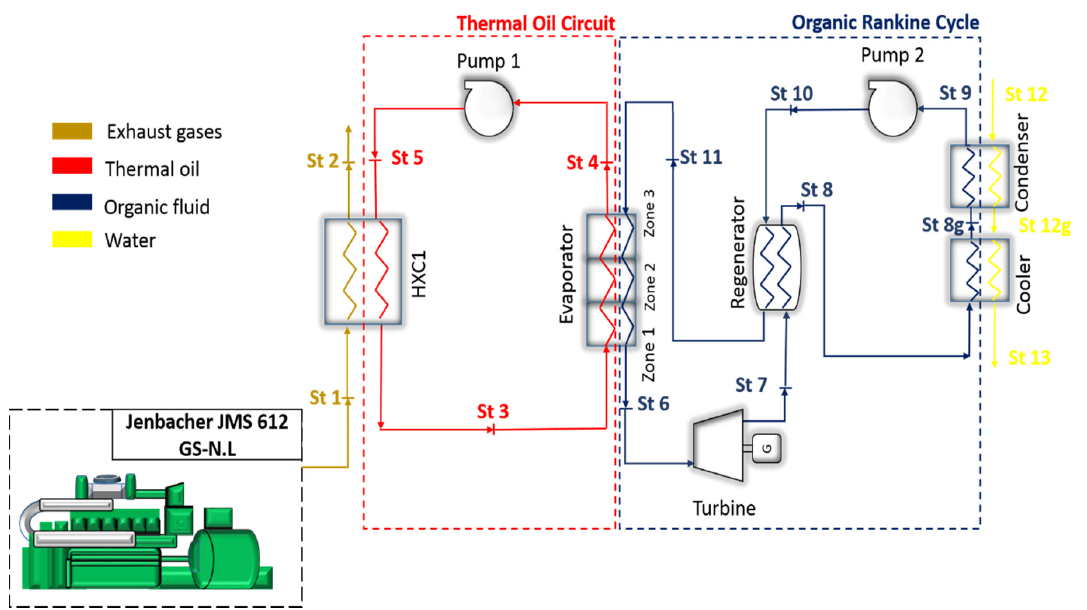
Figure 1. Schematic diagram of the Jenbacher JMS engine integration to the thermal oil cycle configuration and organic Rankine cycle.